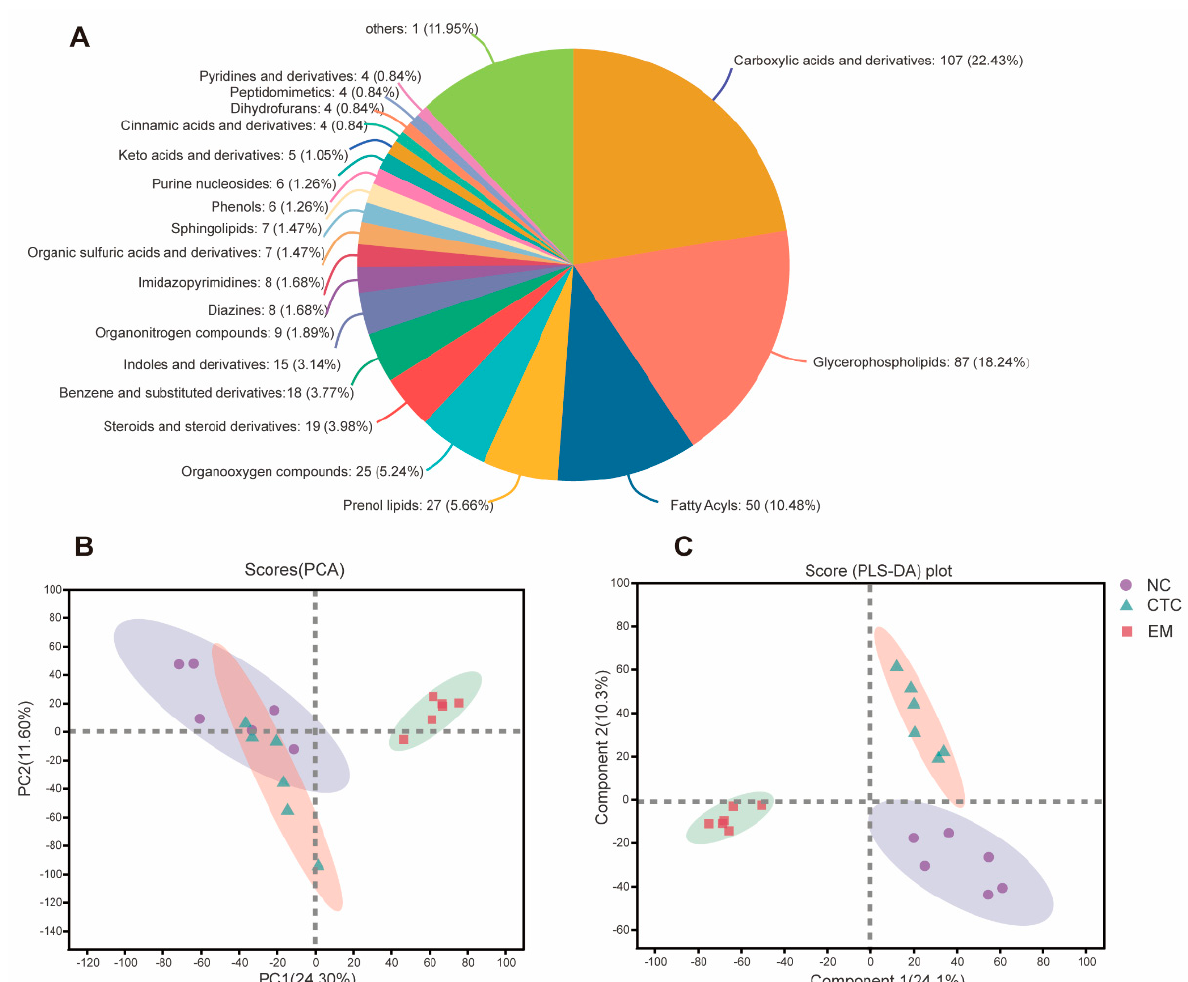
Figure 6. ( A ) Sector diagram showing the classification of broiler serum metabolites based on the HMDB 4.0 database. ( B ) PCA plots of broiler serum metabolomes. ( C ) PLS-DA plot of broiler serum metabolomes.